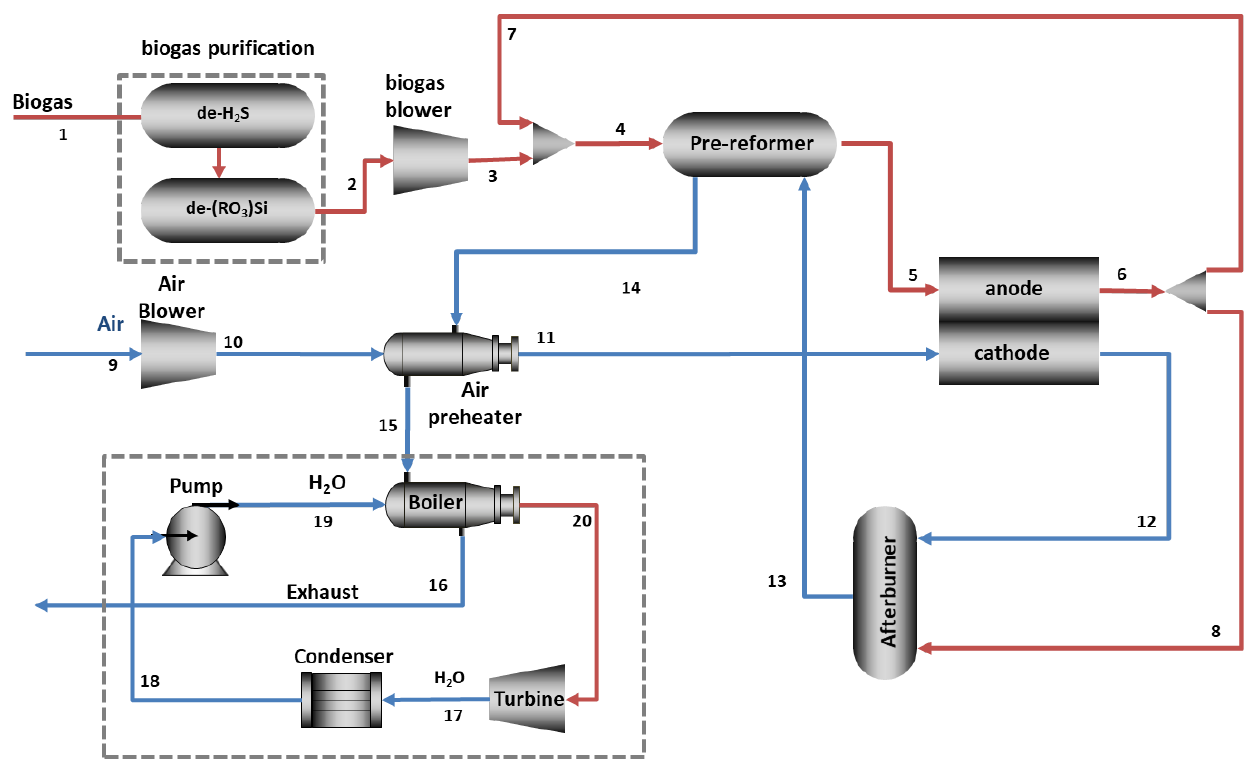
Figure 1. Scheme of the proposed cogeneration process using SOFC cell.